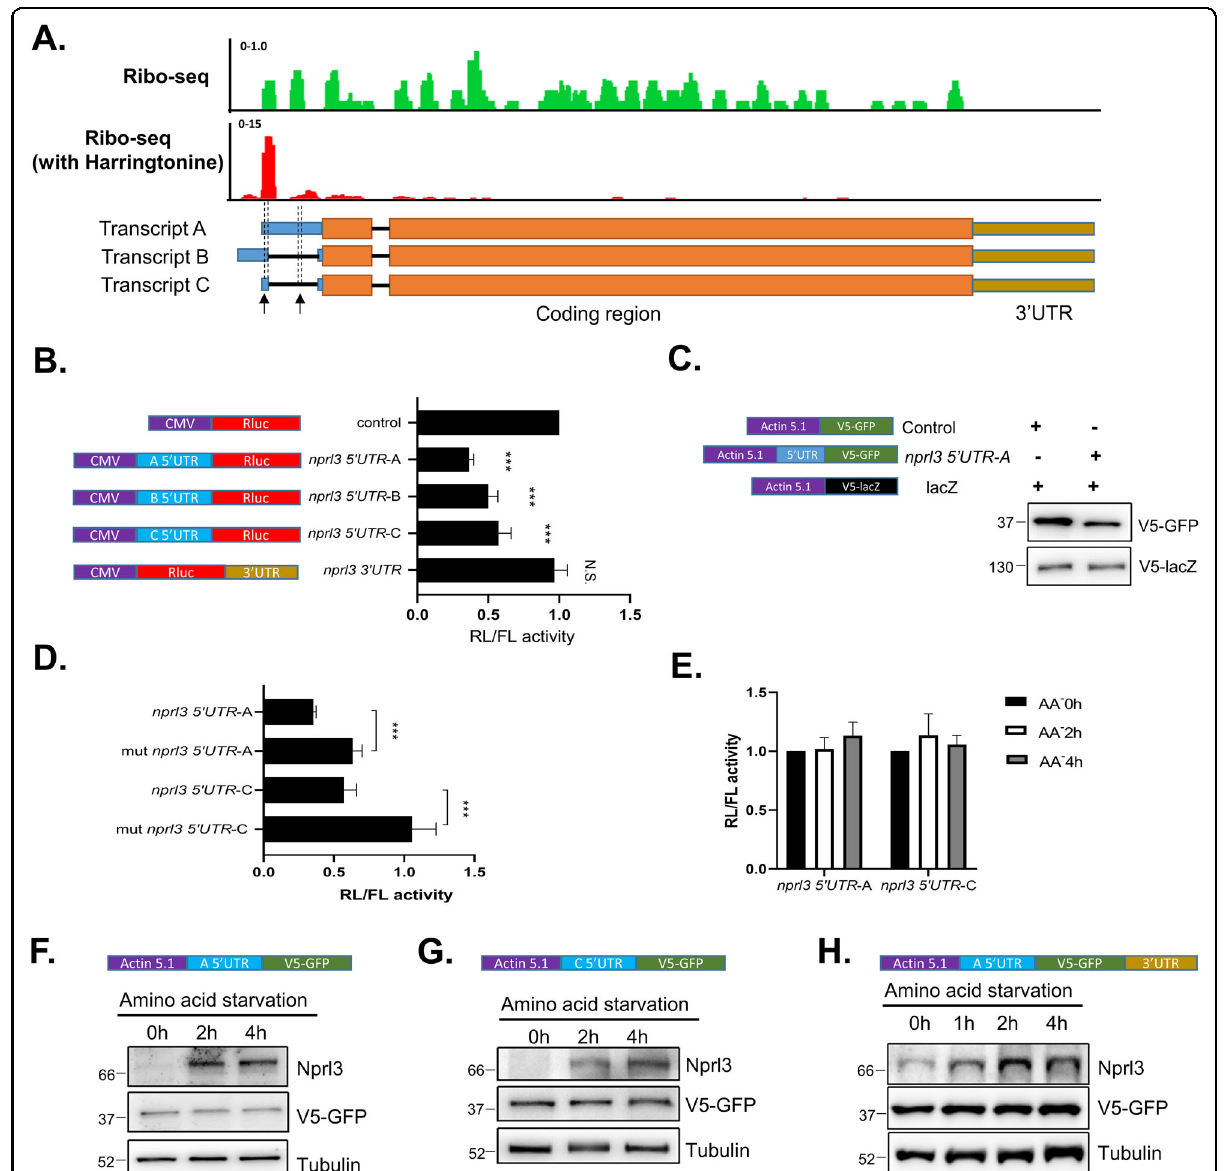
Fig. 7 The nprl3 5 ’ UTR contains functional uORFs. A Ribosome-protected fragment (RPF) reads mapped to the nprl3 transcripts. The green is RPF from S2 cells without treatment, and the red is RPF from S2 cells treated with harringtonine. The three transcripts of nprl3 are depicted. The location of the uORF that exists in all three transcripts is denoted by an arrow, and the main ORF is marked in orange. B S2 cells were transfected with the indicated constructs that inserted nprl3 5 ′ UTR and 3 ′ UTR to control renilla luciferase (RL) expression. The psiCHECK-2 constructs contain fi re fl y luciferase (FL), which were used as for normalization. Values are expressed as fold change relative to the empty construct (Control). Error bars represent standard error values from three independent experiments. *** P < 0.001. C S2 cells were co-transfected with the V5-tagged GFP reporter construct inserted with nprl3 5 ’ UTR and V5-tagged lacZ construct. The levels of V5-GFP and V5-lacZ were detected by western blot. V5-lacZ was used as a loading control for western blot. D S2 cells were transfected with the indicated constructs that inserted wild-type nprl3 5 ’ UTR or the mutant nprl3 5 ’ UTR with the ATG in the uORF changed to GTG. Values are expressed as fold change relative to the empty construct (Control). Error bars represent standard error values from three independent experiments. *** P < 0.001. E S2 cells were transfected with the indicated constructs that inserted wild-type nprl3 5 ’ UTR. Cells were treated with amino acid starvation (AA − ) for indicated hours. Values are expressed as fold change relative to the value before starvation. F – H S2 cells were transfected with the indicated constructs inserted with nprl3 5 ′ UTR or 3 ′ UTR to control GFP reporter expression. The cells were starved for the indicated time, and the V5-GFP was measured with western blot. α -Tubulin was used as a loading control. Similar western blot results were observed in more than three independent experiments for each